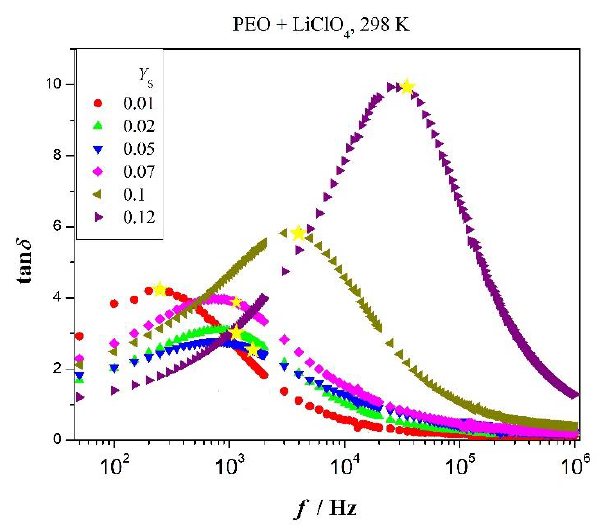
Figure 8. Tangent-loss spectra for T = const and indicated concentration of added salt as parameter; stars mark characteristic frequency f Z min